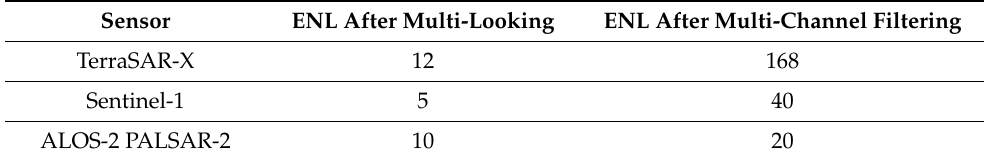
Table 3. Estimates of Equivalent Number of Looks (ENL) for each of the spaceborne SAR sensors used in this